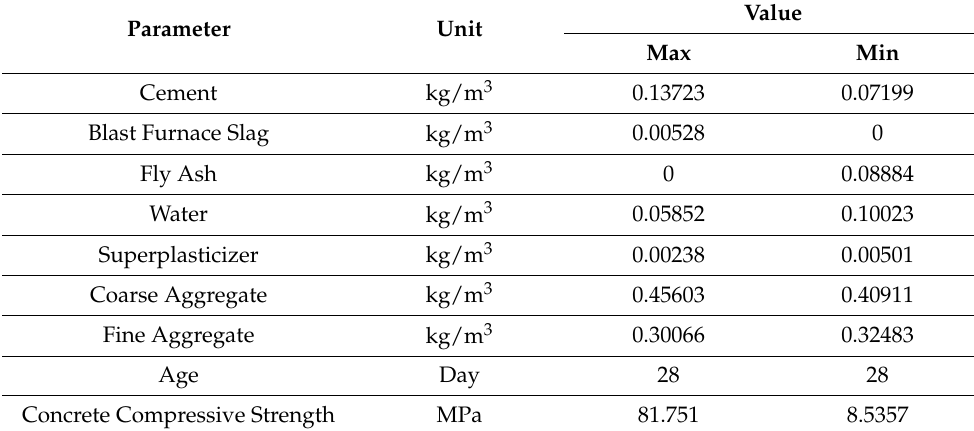
Table 9. The highest and lowest predicted recycled aggregates compressive concrete strength for 28 days